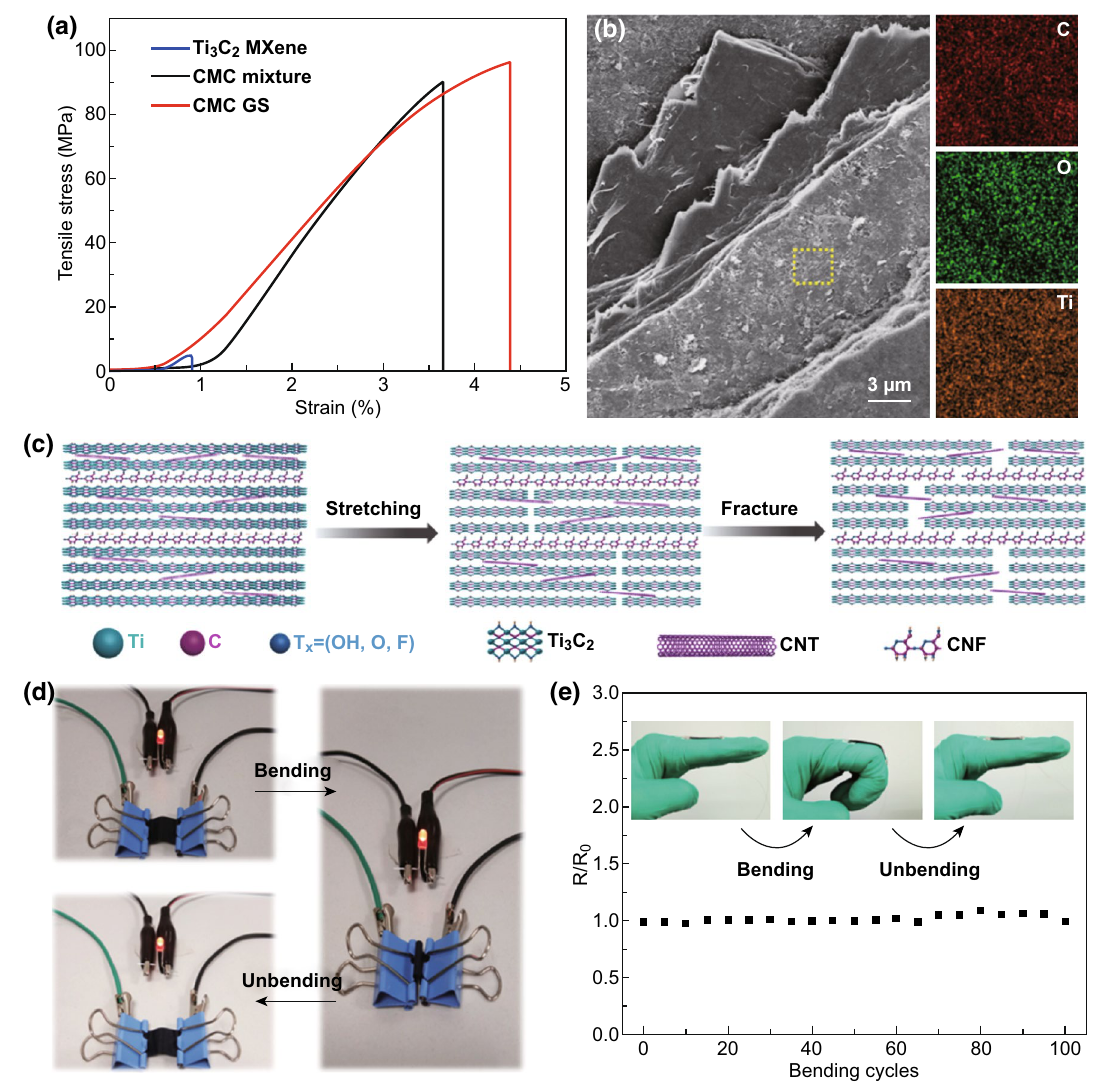
Fig. 3 a Tensile stress–strain curves of the pure Ti 3 C 2 MXene, CMC mixture, and CMC GS composite paper. b SEM image and the corre‑ sponding EDS map of the fracture surface of CMC GS composite paper. c Schematic illustration of the crack propagation mode of CMC GS composite paper. d , e Electrical resistance variation of CMC GS composite paper with bending